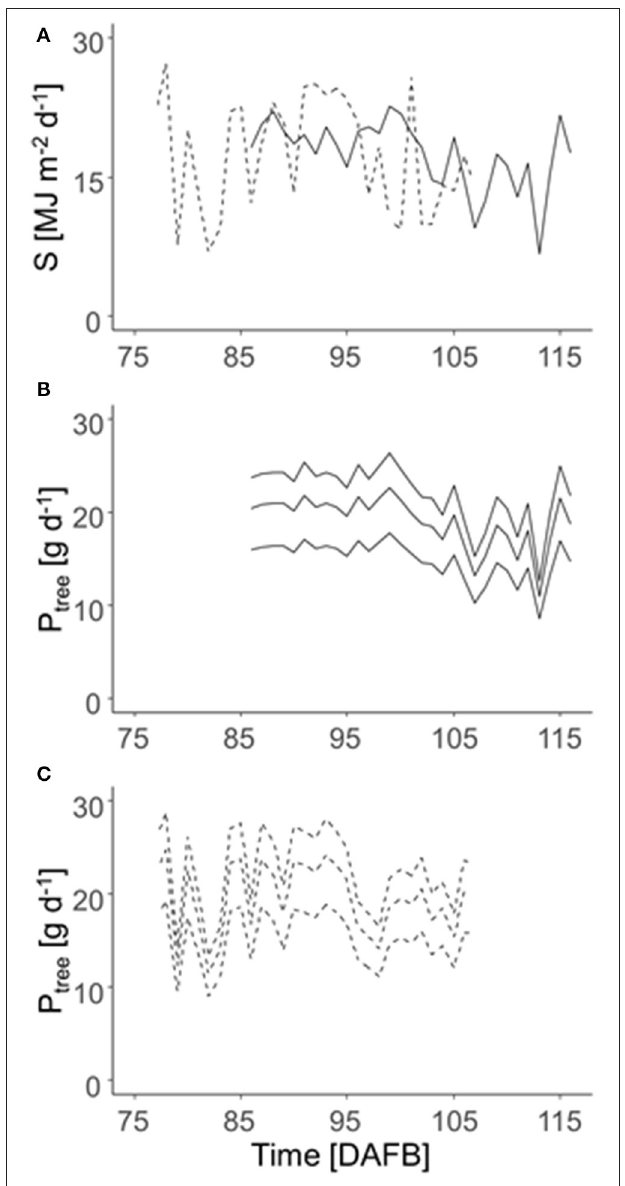
FIGURE 5 | Daily integrated solar radiation (S) in 2018 (solid lines) and 2019 (dashed lines) (A) and daily C gain per tree (P tree ) of ‘Gala’/M9 during the time of maximum daily fruit C-requirement (2018: 86–116 DAFB; 2019: 77–107 DAFB) ( B : 2018; C : 2019). P tree was calculated for the trees of 3.6, 5.5, and 7.7 m ² total LA (lines from the bottom to top), which represents the 5, 50, and 95th percentile of LA LiDAR of all 996 trees measured during both years.